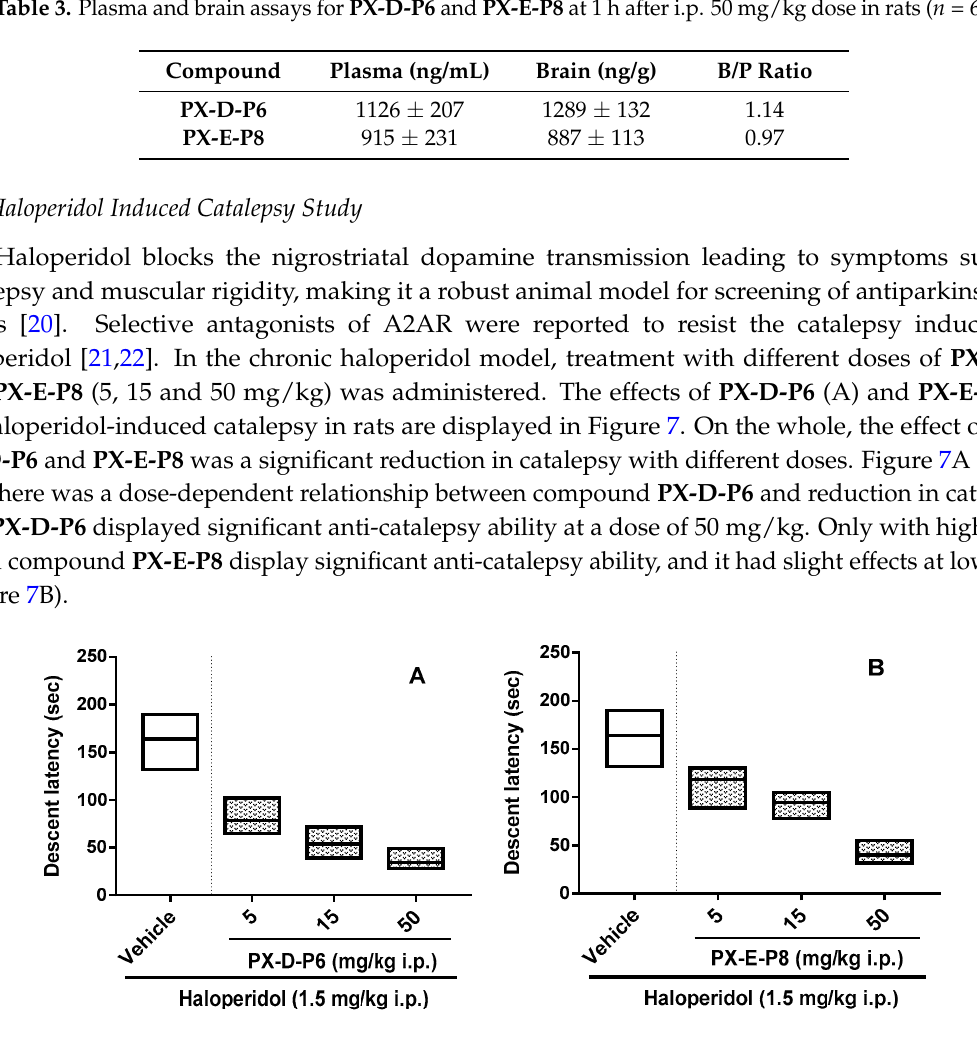
Figure 7. Effects of PX-D-P6 ( A ) and PX-E-P8 ( B ) on haloperidol-induced catalepsy in rats with different concentrations (5 mg/kg, 15 mg/kg, 50 mg/kg). Each column indicates the median and interquartile ranges, and the number of rats used was six, p < 0.05 (Bonferroni's test), compared with the vehicle-treated group.